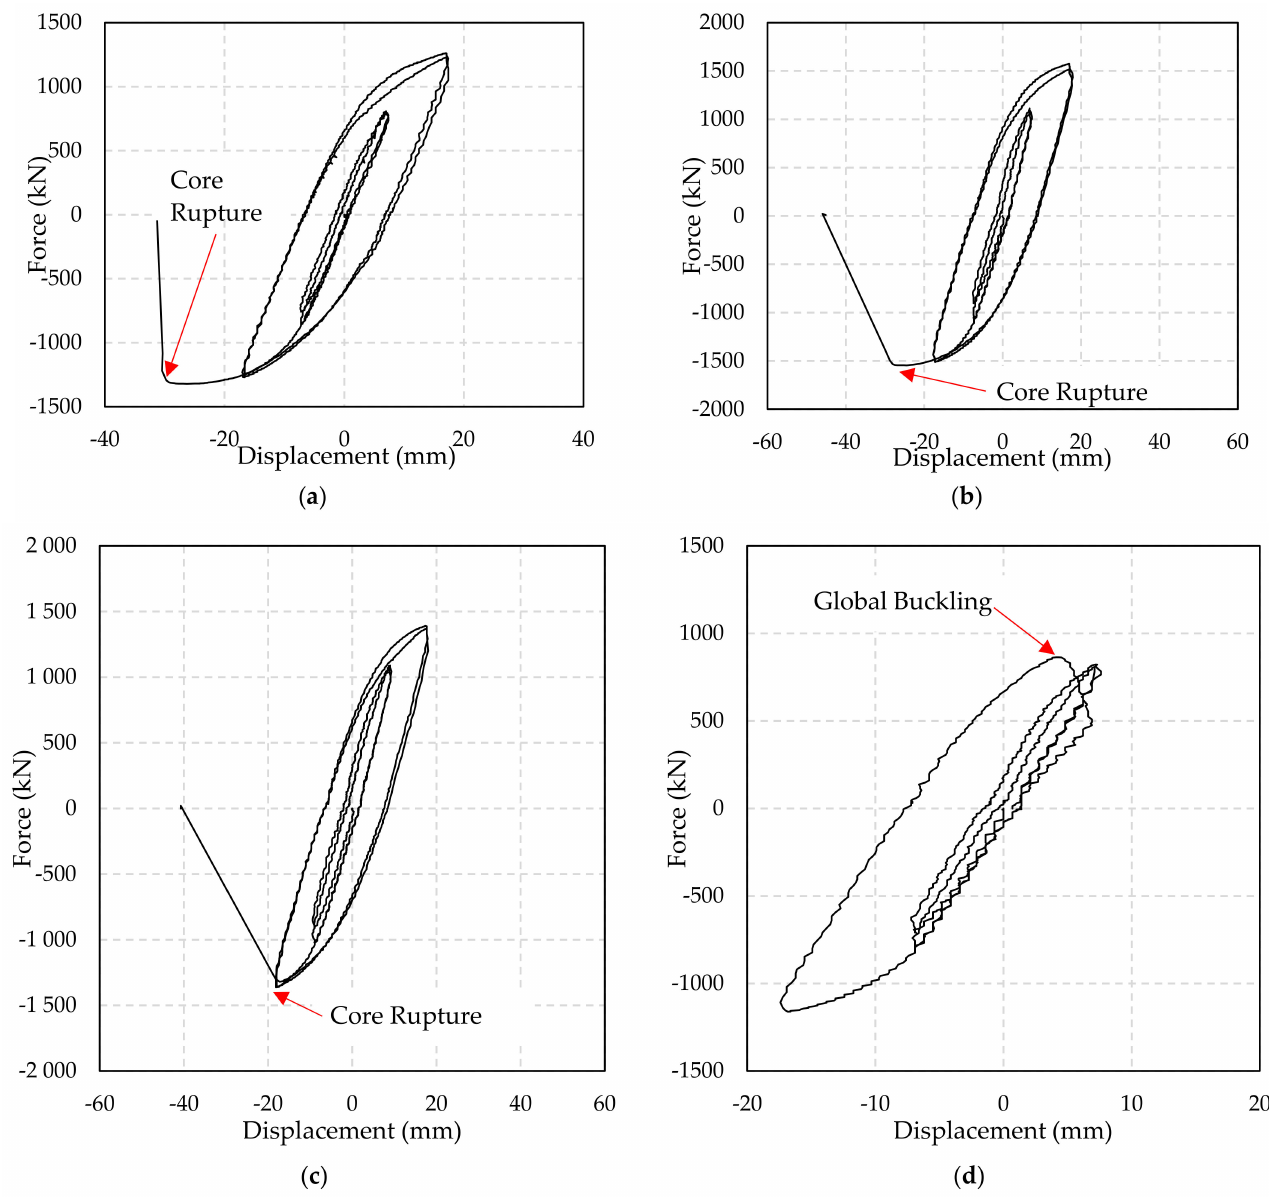
Figure 11. Hysteretic response of circular specimens: ( a ) S125 t9–S200 t9-S ; ( b ) S125 t9–S200 t9-B ; ( c ) S125 t7–S200 t9-B ; ( d ) S100 t9–S175 t6-B